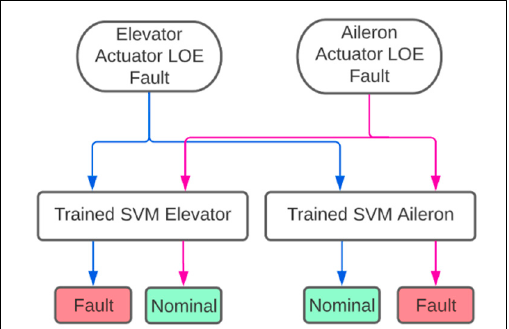
Figure 15. Overview of the aileron and elevator actuator SVM models in